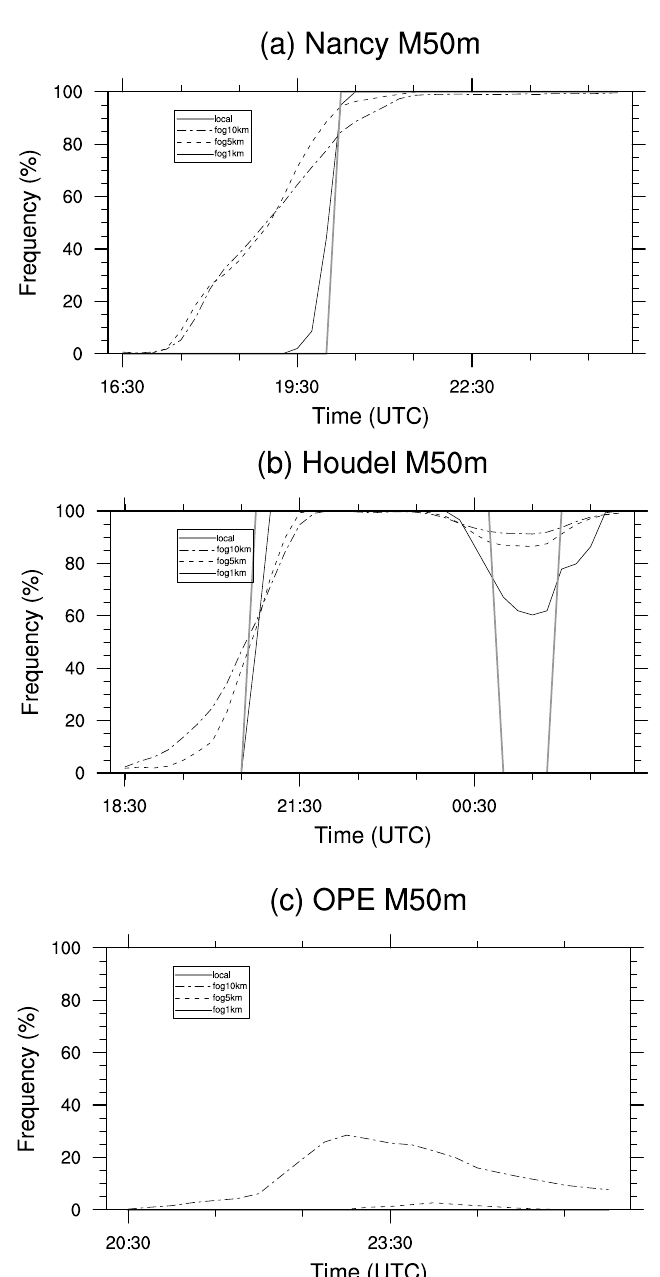
Figure 9. Evolution of the fog coverage at the three observation sites: Nancy ( a ), Houdel ( b ) and OPE ( c ). Coverage is computed at the site points—see Figure 1 (solid grey line), over 1 km black line), over 5 km 5 km (dashed line) and over 10 km ×